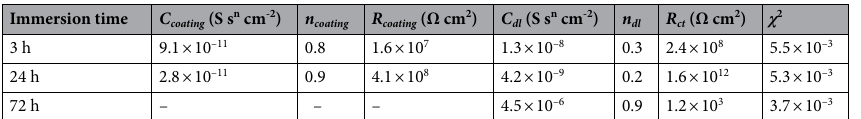
Table 2. Fitted parameters for EIS spectra of AS/Ce-HT specimen depicted in Fig.